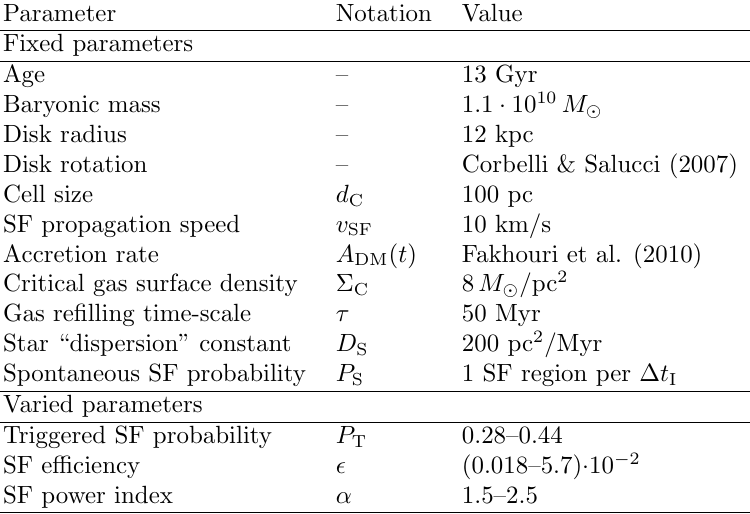
Table 2. The parameters of the 2-D galaxy